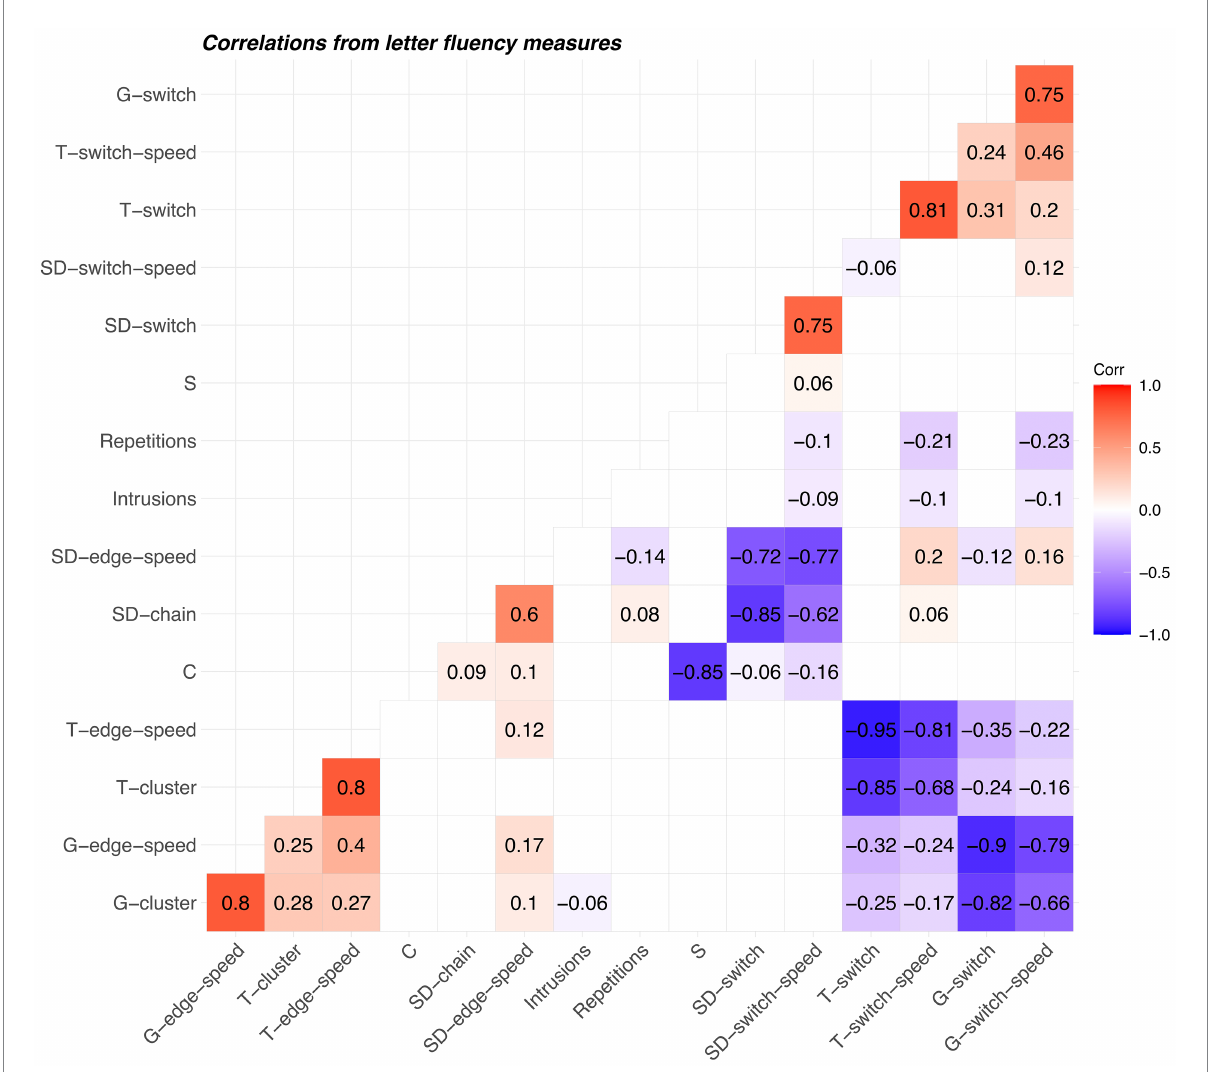
FIGURE 7 Correlation matrix of scores derived from letter fluency. Prior to calculating the correlations, the raw scores were regressed out of all scores tabulated here. Abbreviations are identical to those in Figure